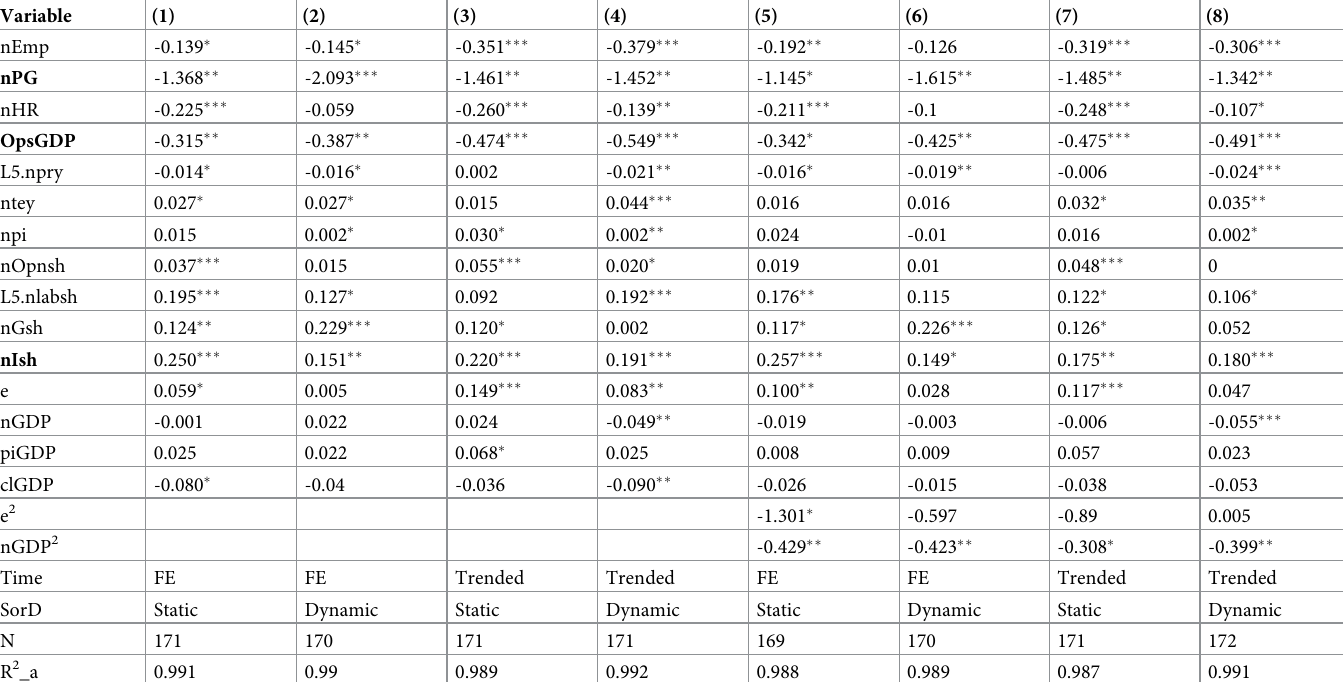
Table 12. Regression results of Gini by